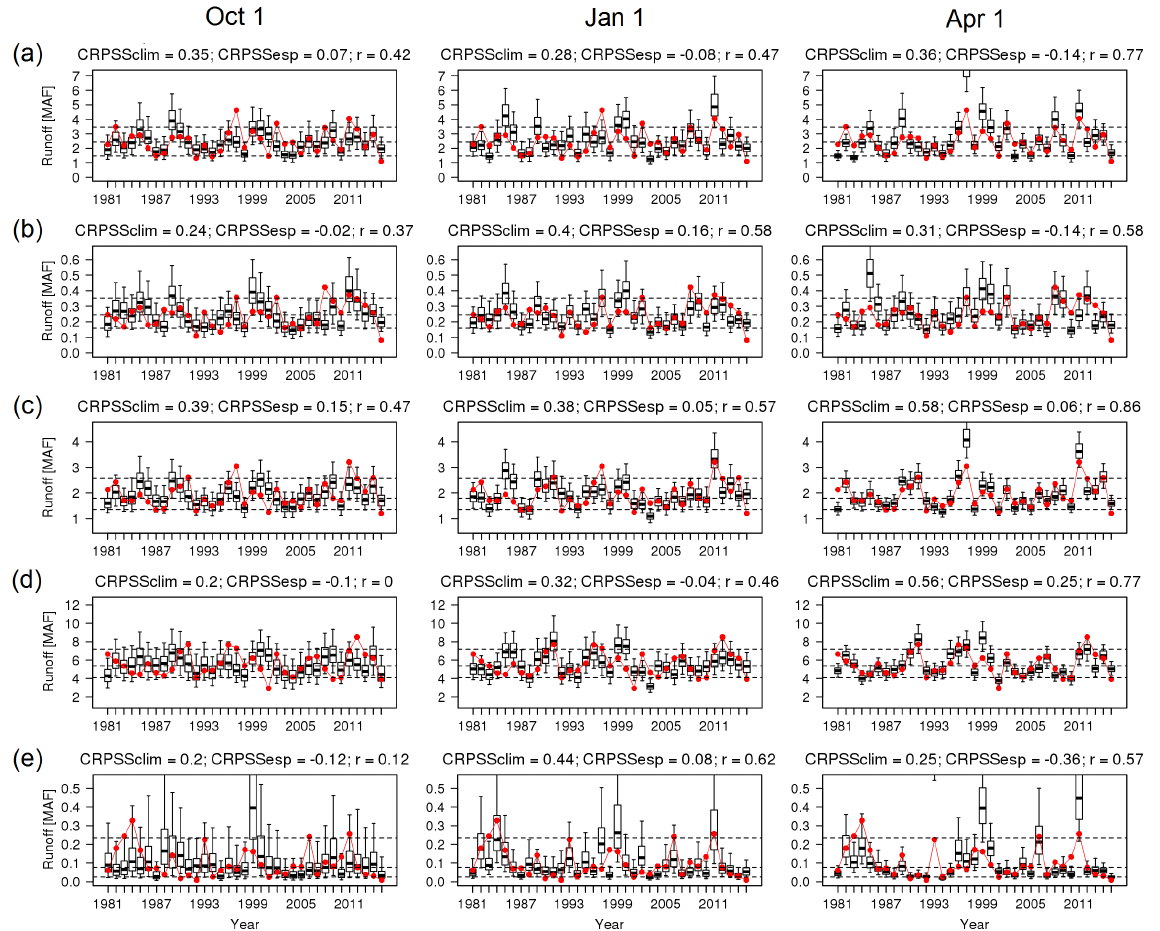
Figure 11. Time series with cross-validated hindcasts obtained with the HESP approach, initialized on (left) 1 October, (center) 1 January, and (right) 1 April. Results are displayed for the five case study locations: (a) Dworshak Reservoir inflow (DWRI1), (b) Howard Hanson reservoir inflow (HHDW1), (c) Hungry Horse reservoir inflow (HHWM8), (d) Libby dam inflow (LYDM8), and (e) Prineville reservoir inflows (PRVO). Black dashed lines represent 10, 50, and 90% flows from the observed climatology, and boxplots show the 10th, 30th, 50th, 70th, and 90th hindcast percentiles. The red line represents the observed flow